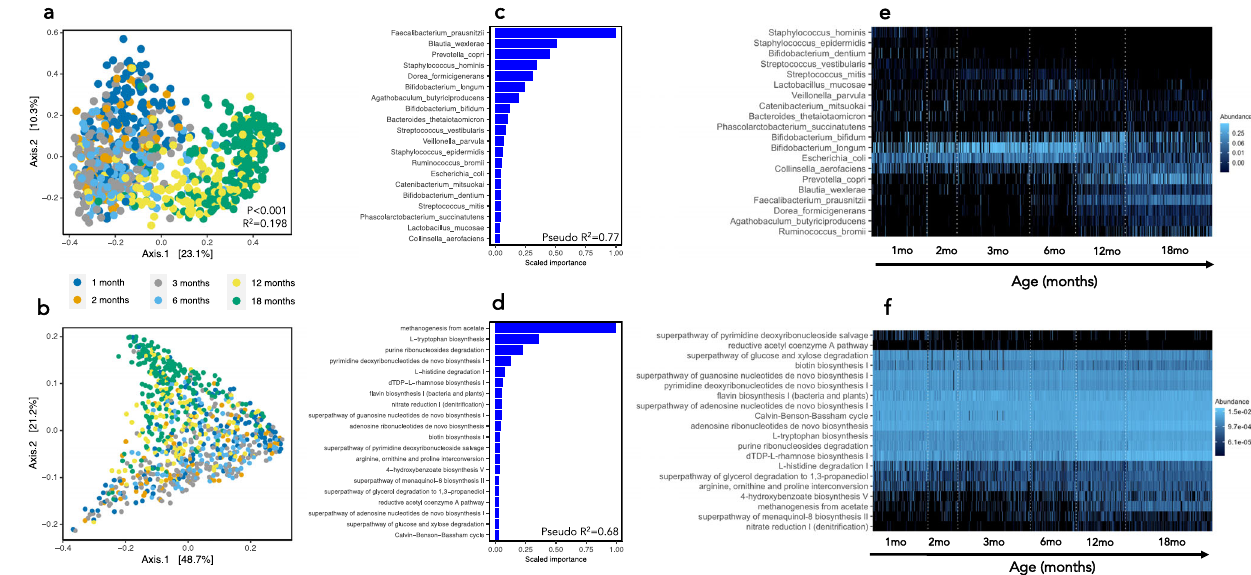
Fig. 1| Compositionaland functionalmaturationofthegutmicrobiomeof335 infants from rural Zimbabwe from 1 – 18months of age. PCoA of Bray-Curtis distances of species ( a ; PERMANOVA; two-sided, p <0.001) and metagenomic pathways( b ;PERMANOVA;two-sided, p <0.001)colouredbyagecategory.Thetop